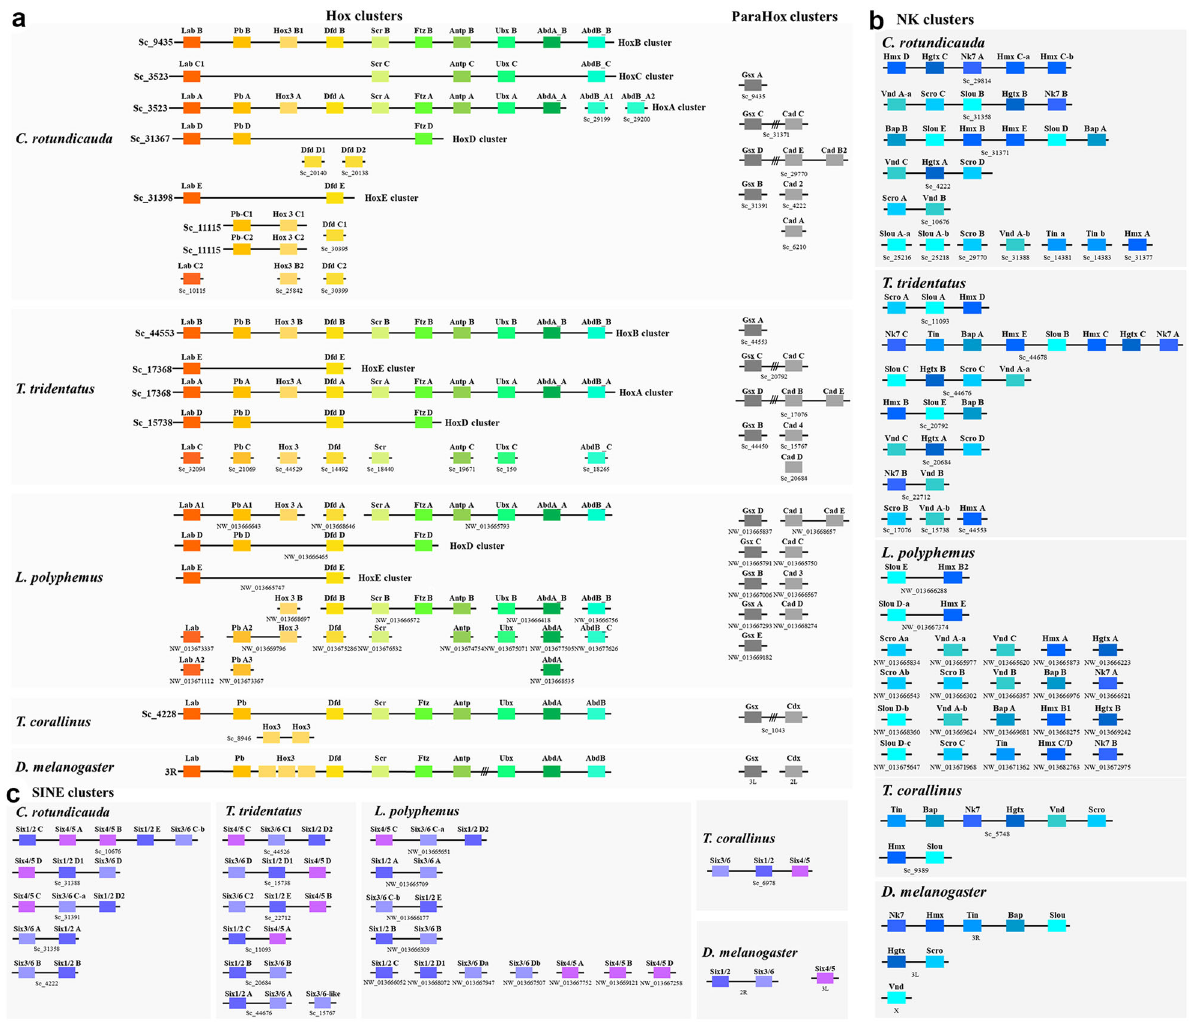
Fig. 2 Homeobox gene organisation. a Genomic organisation of the Hox (left) and ParaHox (right) cluster genes in the horseshoe crab genomes. b Genomic organisation of the NK and c SINE cluster genes in the horseshoe crab genomes. Note that the L. polyphemus genome assembly (GCF_000517525) was obtained from Battelle et al.